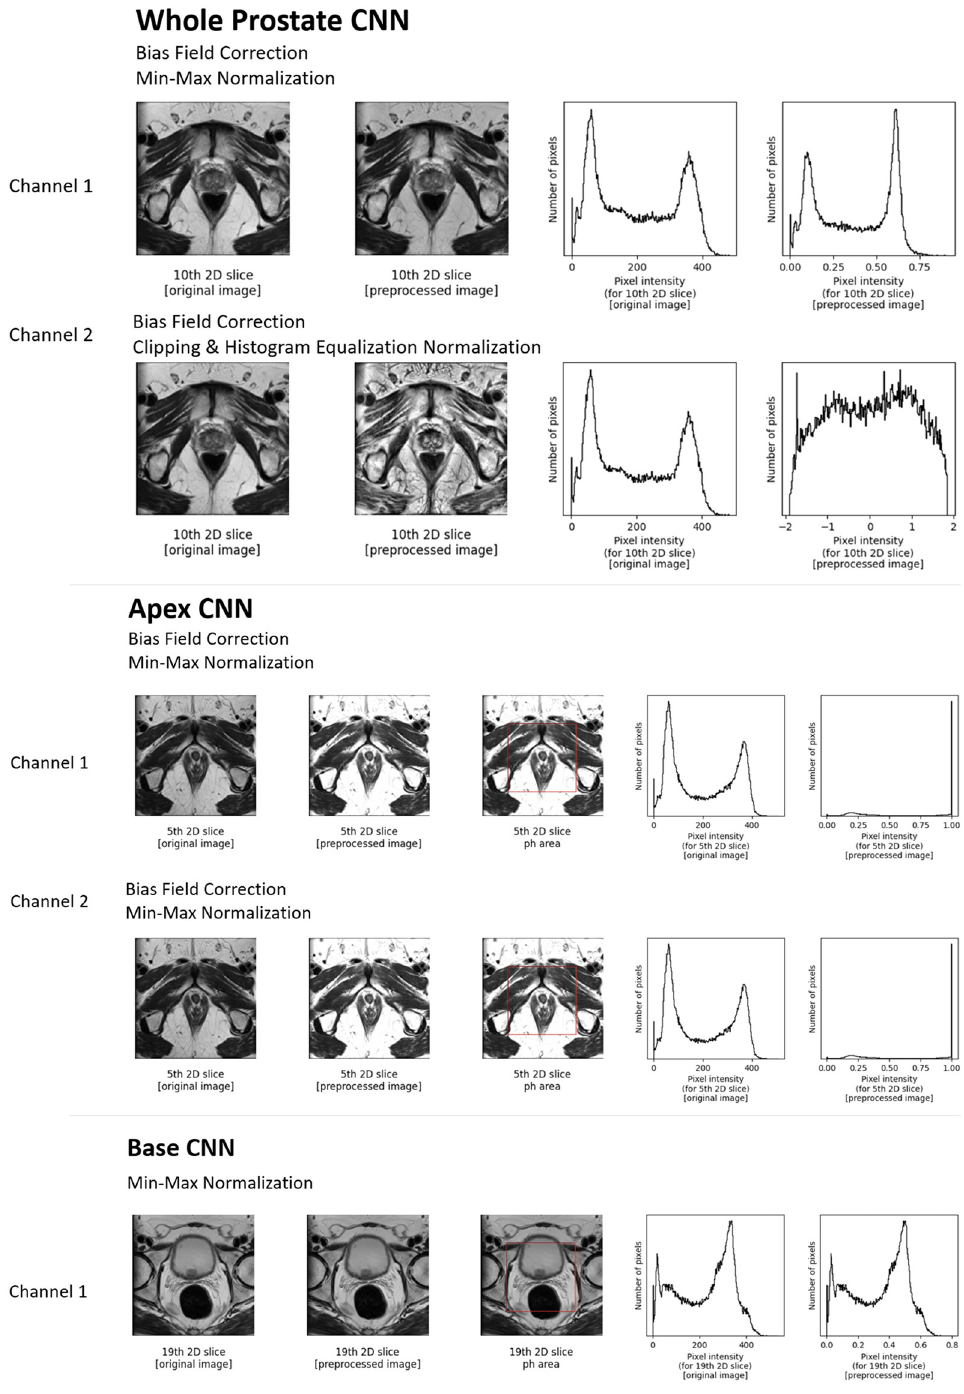
Fig 13. Example 2D image slices and their associated pixel intensity histograms before and after preprocessing. Through KNoLO, an optimal combination of preprocessing steps and input channels was found for each prostate region specific CNN, resulting in the displayed example